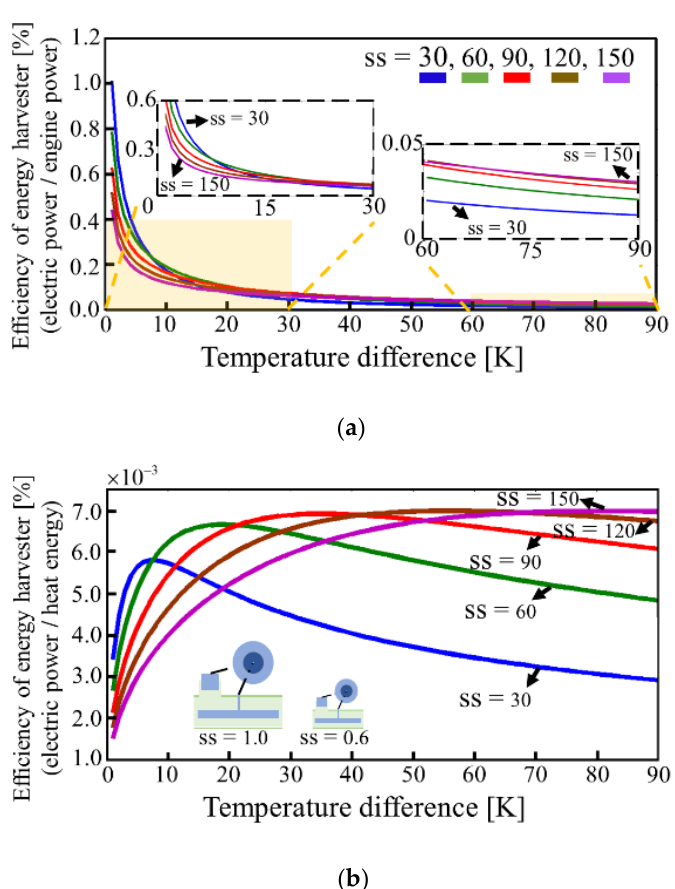
Figure 11. Results for the dimensional efficiency (dimensional number = 30, 60, 90, 120, and 150) of the Stirling engine energy harvester at various temperature differences. Conversion efficiency of ( a ) engine power into electric power for the Stirling engine energy harvester and ( b ) heat energy into electric power for the Stirling engine energy harvester.